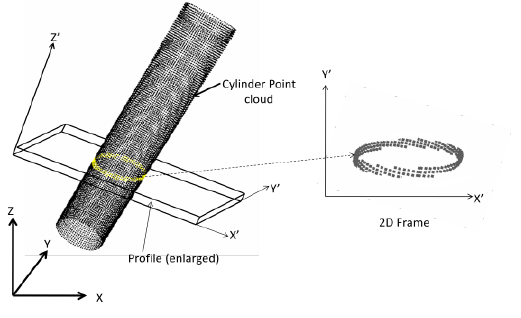
Figure 5.Intersection of a profile and cylinder point cloud produces an ellipse that fulfils properties in section 4.1 3.3.2 Detecting the axes of primitives : Points in a profile will trace out an ellipse if the profile cuts the axis of a piping primitive at a sharp angle. If ellipses are fit to points in each profile, they will exhibit the properties described in section